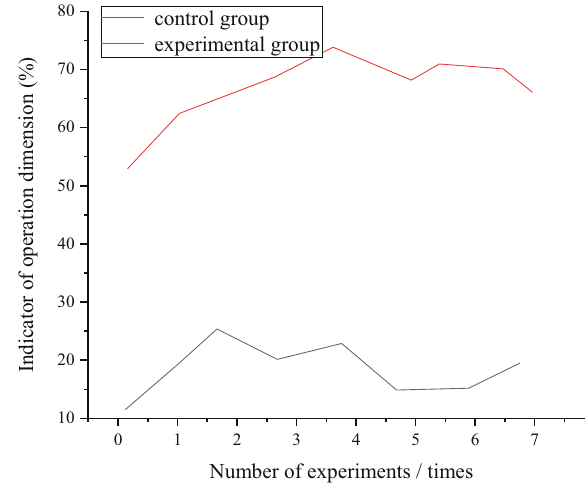
Figure 2: Comparison of the situation index of the perception operation